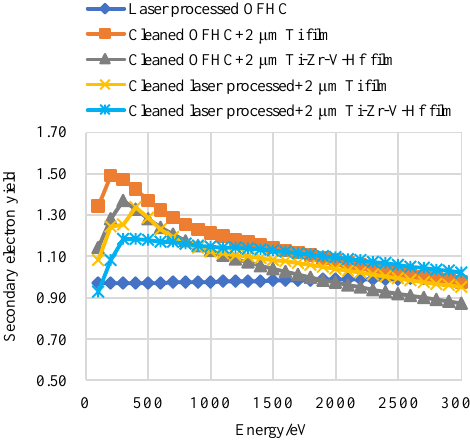
Figure 5. The secondary electron yield (SEY) of laser processed OFHC, Ti film, and Ti–Zr–V–Hf coated laser processed OFHC substrates.